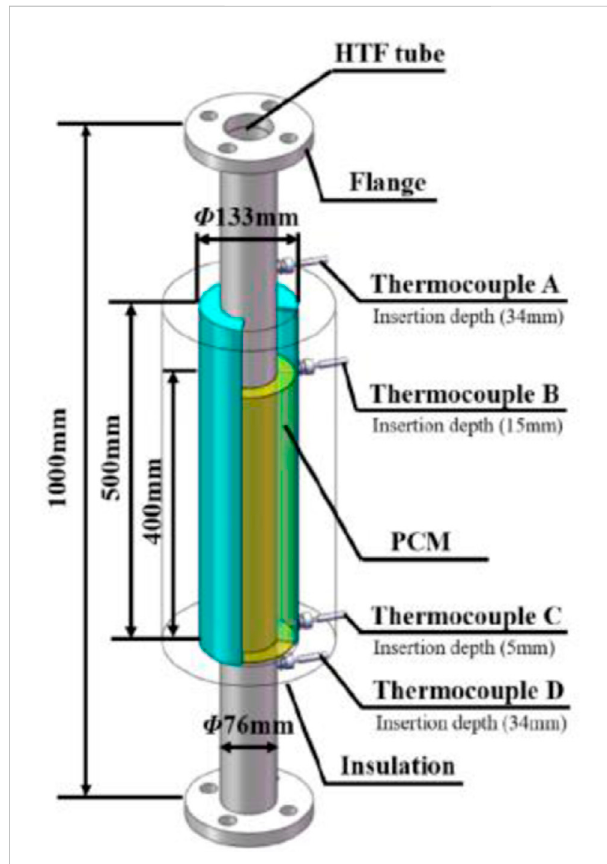
FIGURE 9 Photographic view of the investigational setup of PCM thermal energy storage system (Yuan et al., 2018). License Number: